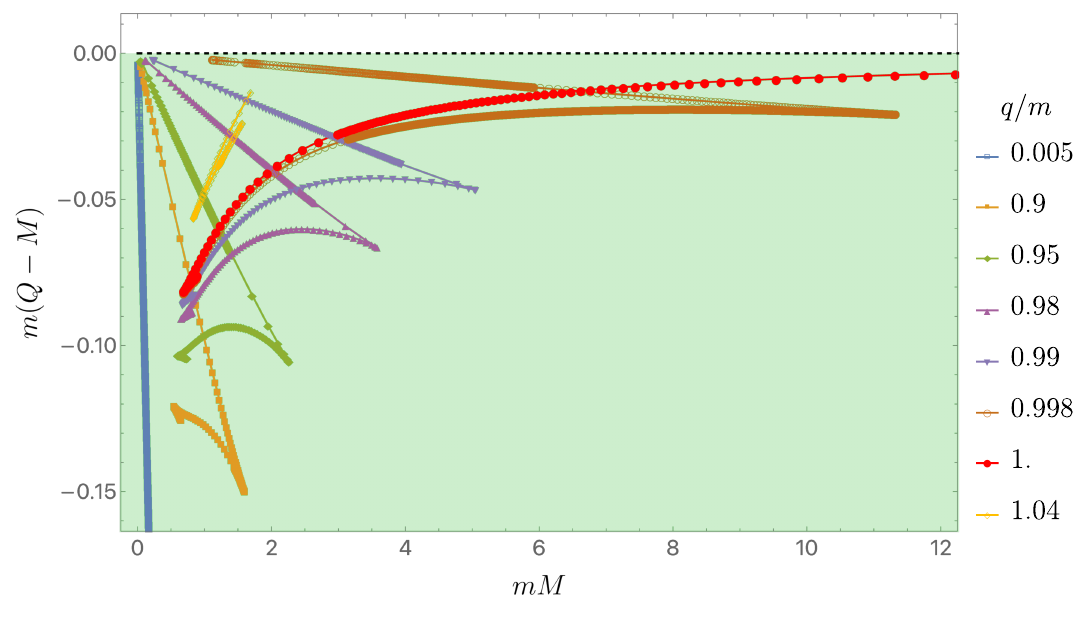
Figure 9 . Moduli space of solitonic solutions for fixed α = 1 , and for several values of q/m labelled on the left. The green region indicates where RN black holes